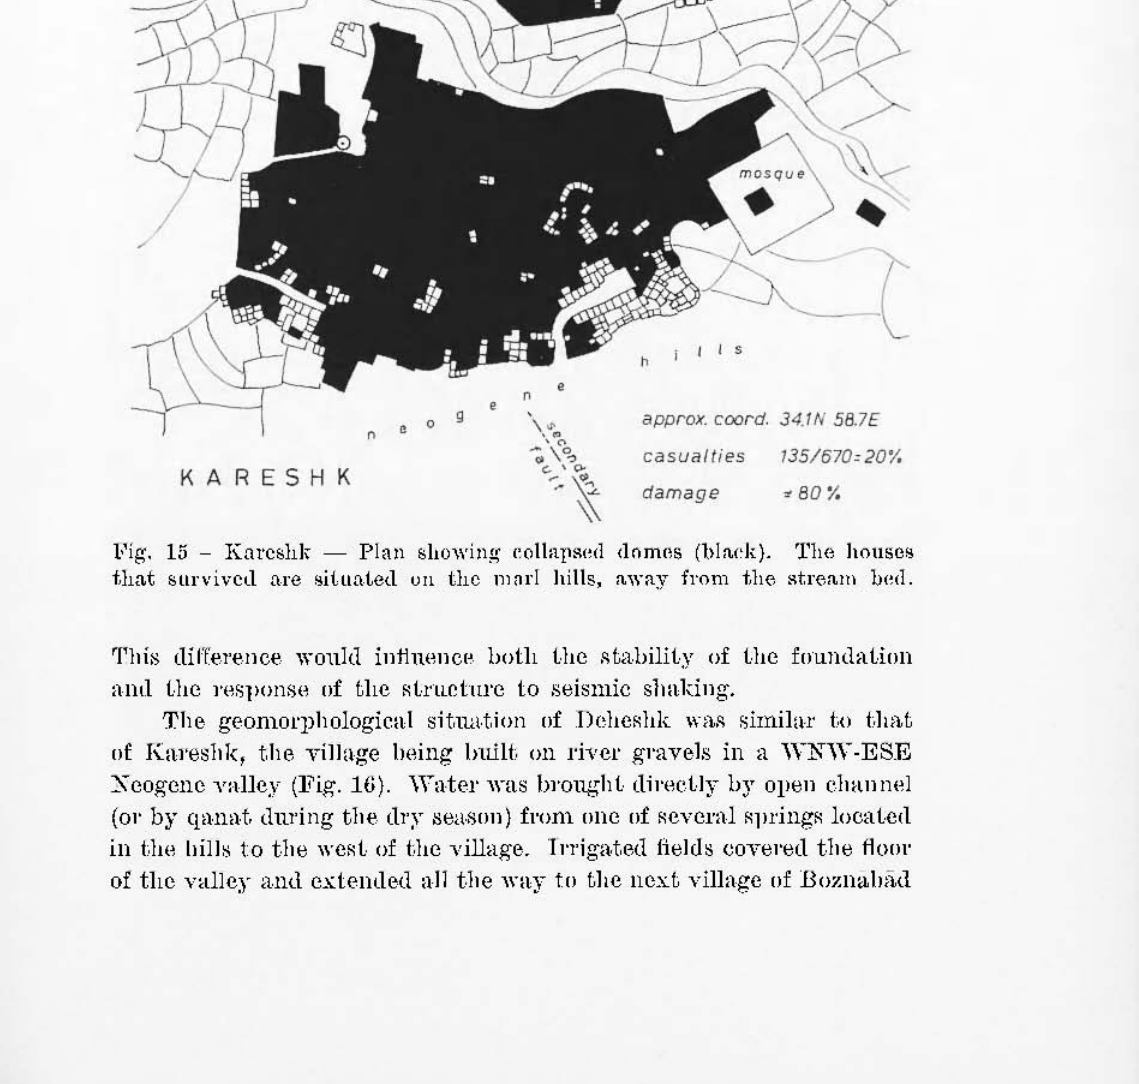
'1'his dilTerellce would intlumlCP hotlt thc ,~tahility of thc foundat-ion ant! thc l'(;spons(; of tItc HtructuI'c to seismic shaking. The gcomol'})hological sit.uat.ion of DehcHhk waH similar t~) t.Ita,t of Kal'e8hk, t.he vili age lwiug lmilt. on l'i-vcr gmvels in a 'YKW-ESE ~cogcne yallcy (li'ig. 16). 'V'ateI' was bl'Ought dilw'Uy hy open ehannel (01' by q~Hmt, dUl'ing the dI)" sen,,>on} hom onc of Hcvcl'al H]JringH locatctl in t.lw hill~ to t.he \VCHt of t.hc 'village. T1'l'igat.ed field8 eOYeJ'ell t.he tiOOl' of tIte vallcy and cxtcnded ali t.hc ,nty to thc next villagc of